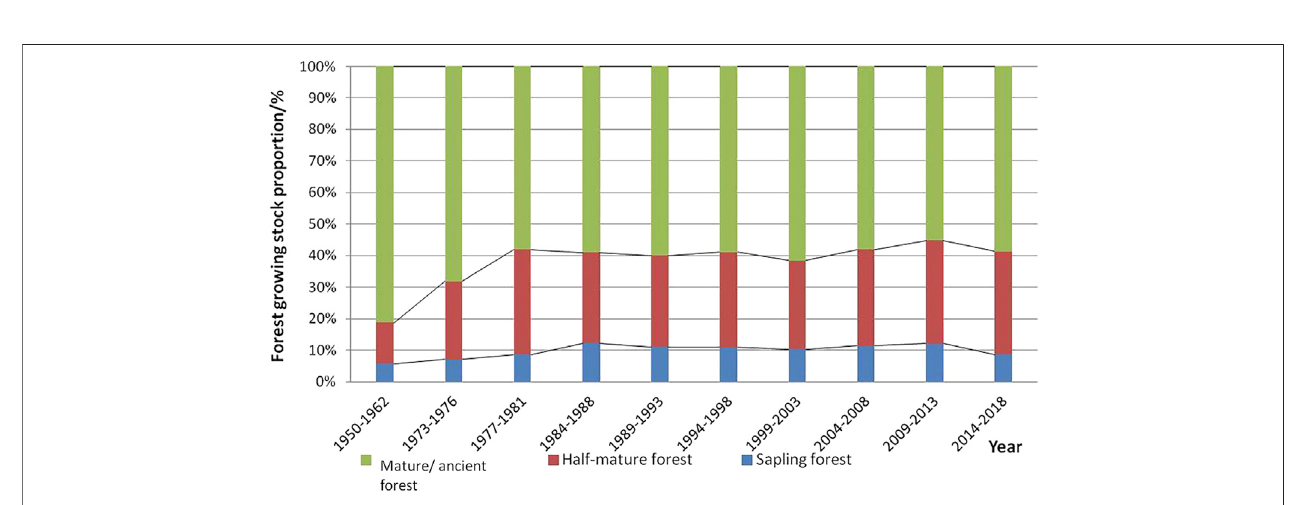
FIGURE 9 | Forest growing stock proportion of different